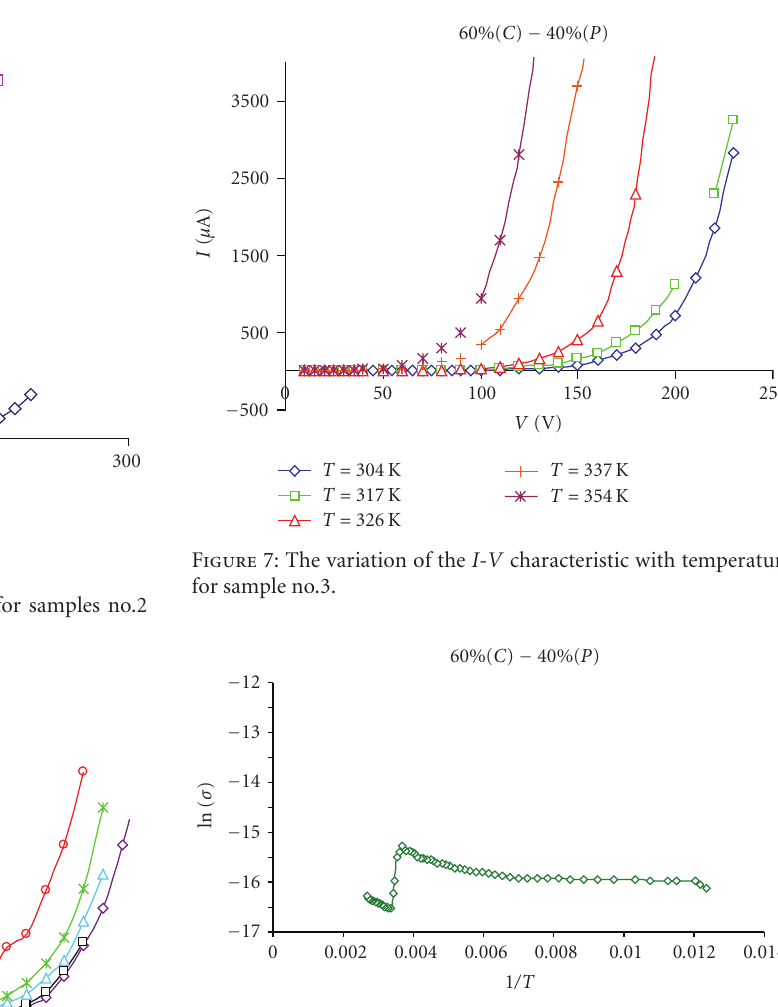
Figure 8: The ln σ ∼ 1 /T curve for sample